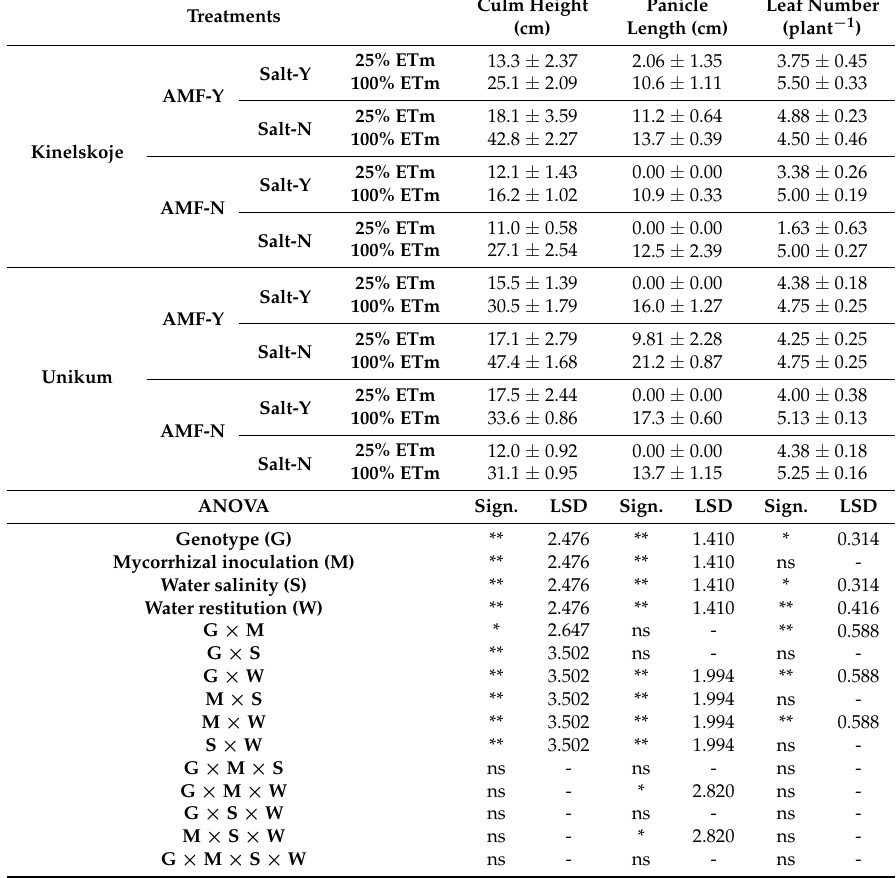
Table 3. Bio-morphological proso millet characteristics. ETm: maximum crop evapotranspiration. Treatments